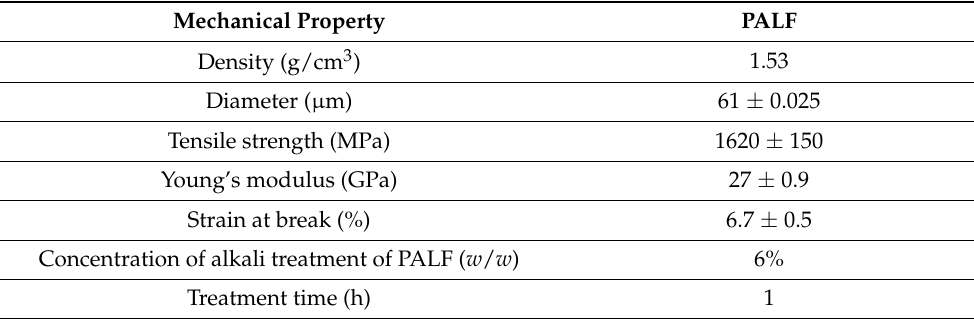
Figure 1. Extracted Pineapple leaf fiber (PALF). Table 1. Mechanical Properties and Alkali Treatment Conditions of the PALF used as reinforcement in this work [21].